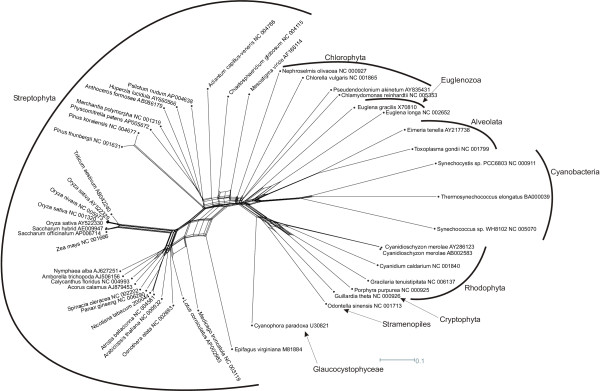
Neighbor-net reconstruction based on GBDP distances between whole plastid genomes. Here, the GBDP variant was derived by scaling and averaging distances based on HSP search with BLASTN and TBLASTX, respectively. Further settings were use of equations (2) and (5) and averaging of asymmetric distance values. The resulting distance matrix achieved the globally lowest δ value (0.1629) and, hence, globally highest distance quality. The highest c-score (topological accuracy) obtained with this matrix was 0.6596 (using BIONJ or STC as phylogenetic reconstruction method). Bacterial outgroup taxa and major eukaryotic groups are indicated. Note the apparently incorrect placement of the highly reduced genome of Epifagus virginiana. Other results are similar to Fig. 4; e.g., most major eukaryotic groups are well recovered.